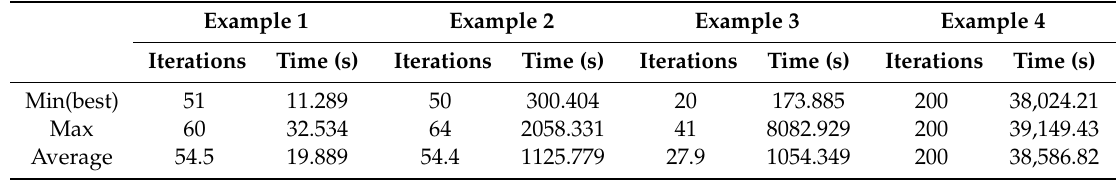
Table 3. Statistics of the iteration and computing time.